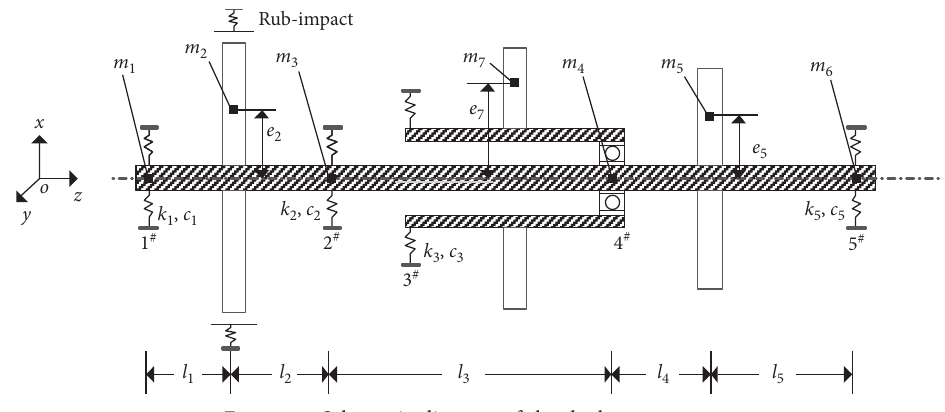
Figure 1: Schematic diagram of the dual-rotor